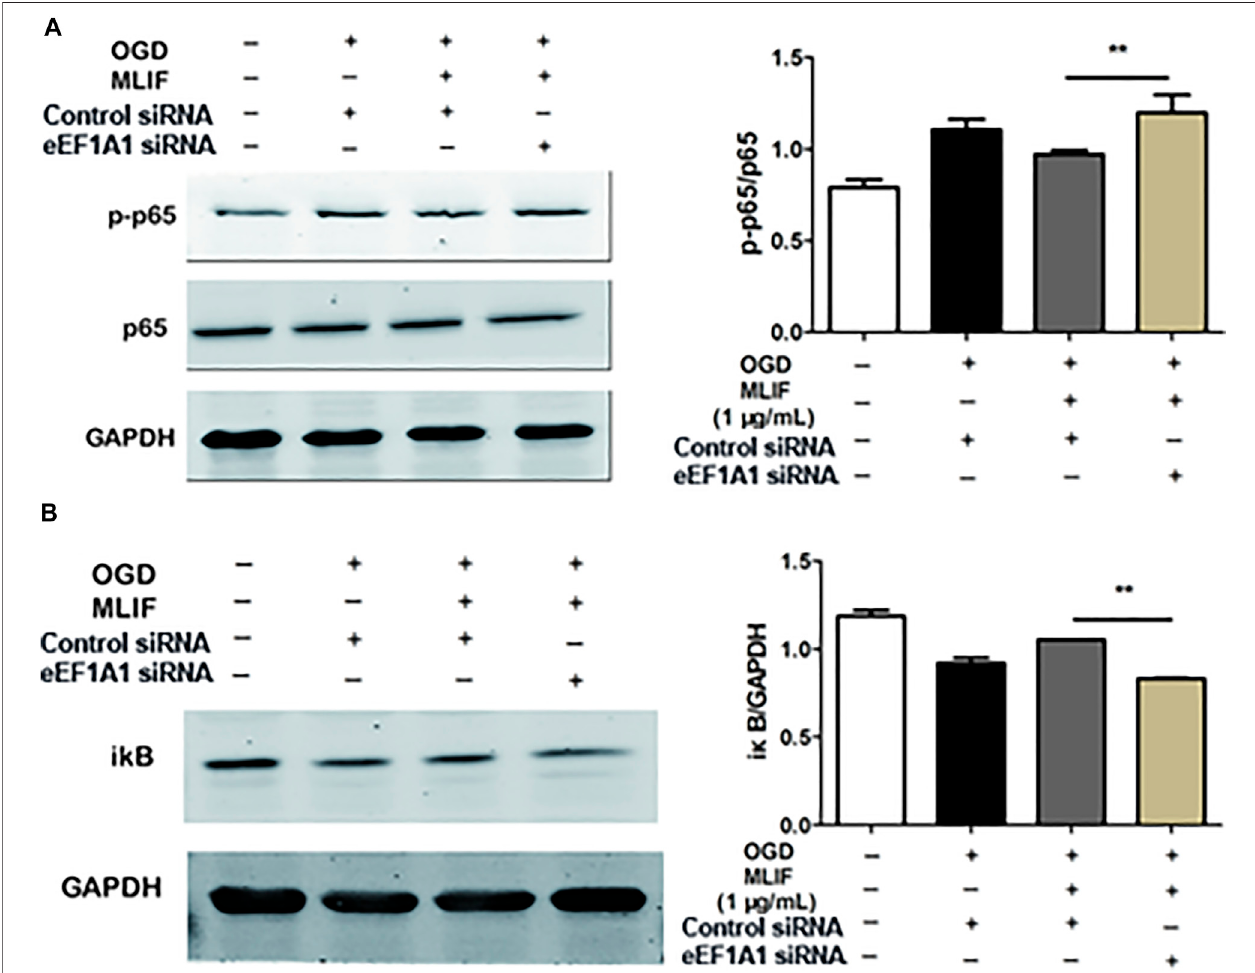
FIGURE 6 | MLIF suppressed the NF- κ B pathway via eEF1A1. After knock-down of eEF1A1 by using eEF1A1 siRNA or control siRNA, OGD-exposed BV2 microglia were incubated with MLIF (1.0 μ g/ml). The levels of p-p65 (A) and i κ B (B) were evaluated by immunoblotting. Data are expressed as the mean ± SEM. N (cid:1) 3. ** p < 0.01 vs Control siRNA